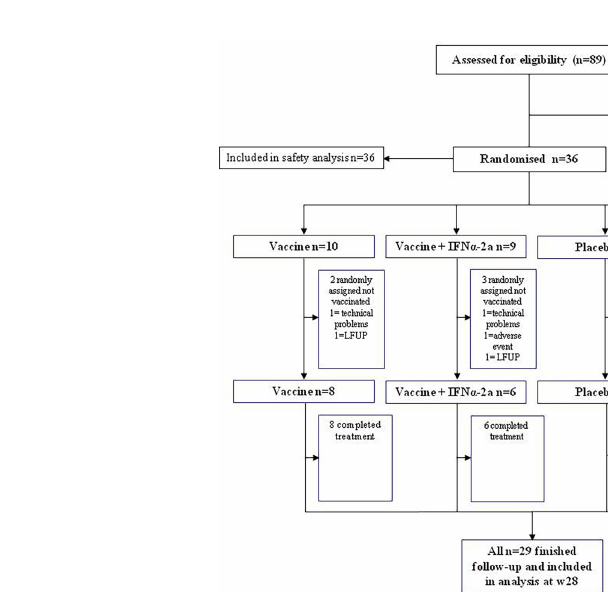
TABLE 1 | Baseline characteristics.